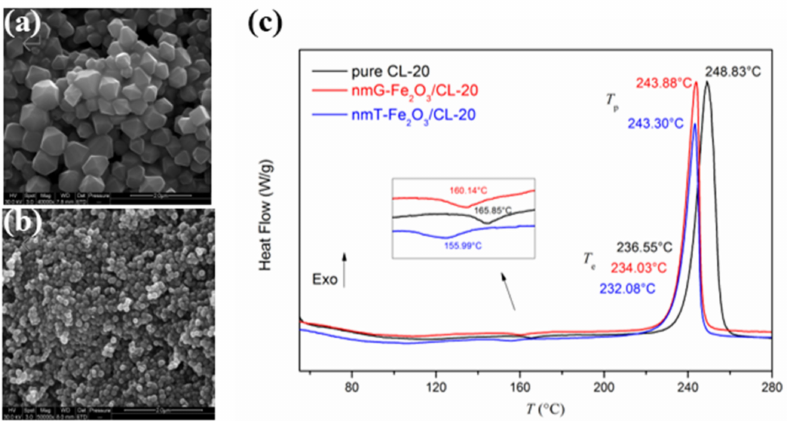
Figure 3. SEM images of the two nano-Fe 2 O 3 with a resolution of 2 µ m. ( a ) tetrakaidekahedral -Fe 2 O 3 (nmT-Fe 2 O 3 ), ( b ) grainy-Fe 2 O 3 (nmG-Fe 2 O 3 ) and DSC curves of CL-20, nmT-Fe 2 O 3 /CL-20 and nmG-Fe 2 O 3 /CL-20 at a heating rate of 10 K · min − 1 ( c ). ( a – c ) Reproduced with the permission of ref. [38]. Copyright 2016, Propellants Explosives